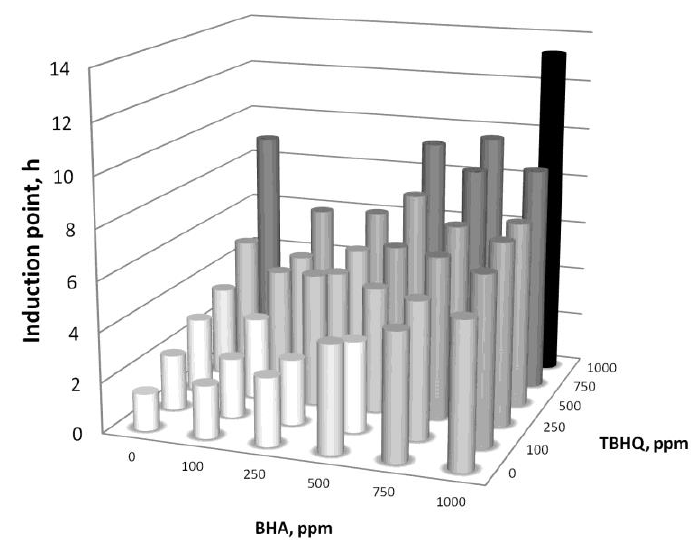
Figure 7. E ff ect of BHA and TBHQ mixtures on oxidative stability of sa ffl ower Figure 7. Effect of BHA and TBHQ mixtures on oxidative stability of safflower biodiesel.